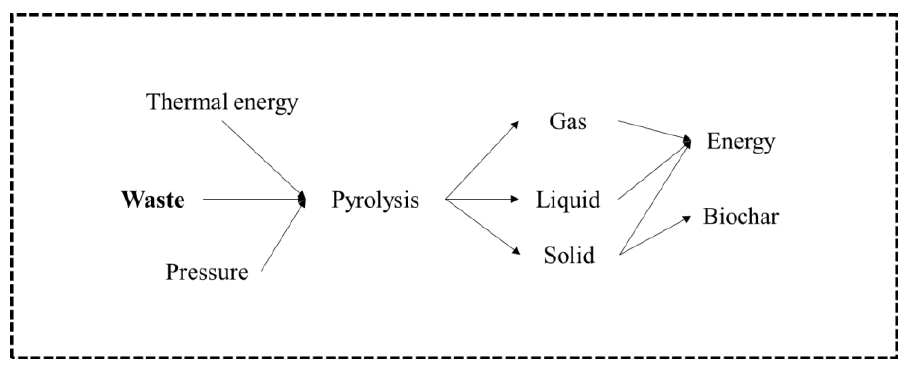
Figure 6. Pyrolysis process model